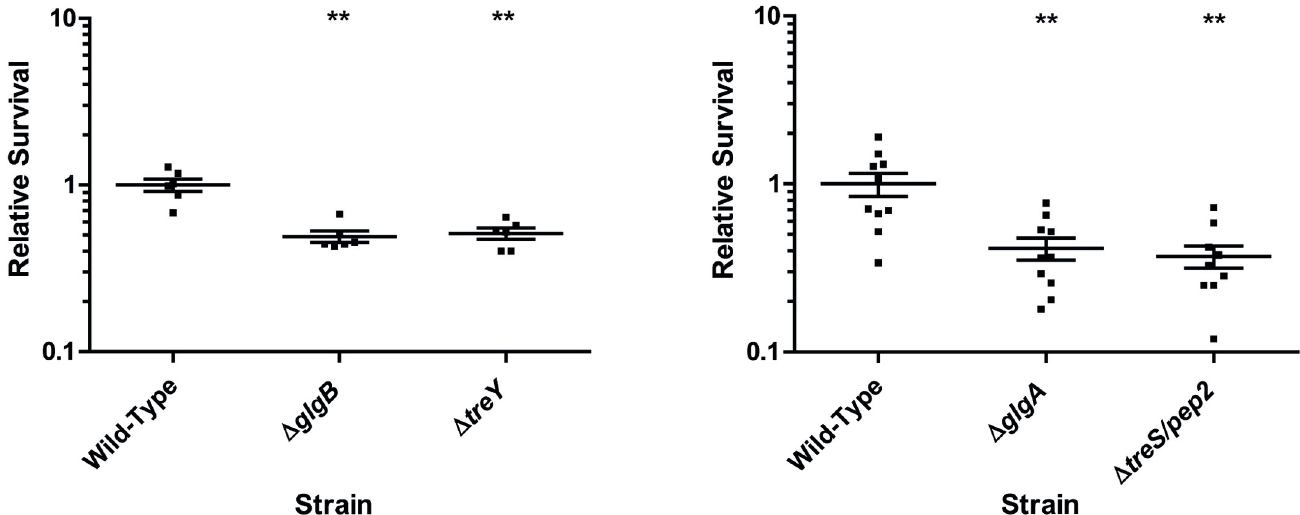
Fig 11. Survival of PAO1 mutant strains on a steel work surface. Scatter graphs showing recovered CFUs for PAO1 mutants after 24h incubation on a sterile brushed steel work surface, relative to WT PAO1. X-axis shows different tre / glg mutants, Y-axis shows recovered CFUs as a fraction of the mean WT value. Individual data points are shown, with mean values ± standard error indicated with bars. Significant differences from the WT are shown with asterisks (Mann- Whitney U test, �� : p < 0.01). Experiments were conducted at least twice independently for each mutant and representative assays versus WT PAO1 are shown in each